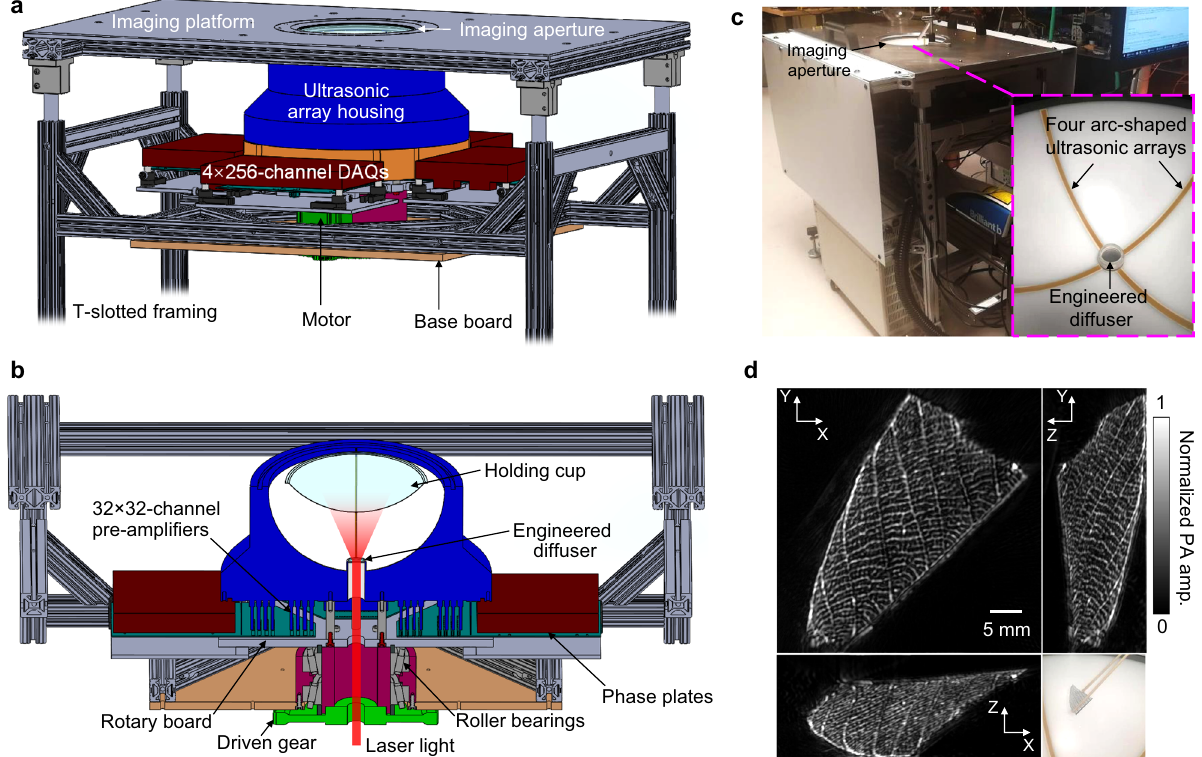
Fig. 1 Representations and photographs of the 3D-PACT system and the leaf skeleton images. a Perspective view of the system. DAQ, data acquisition module. b Cut-away view of the system with the imaging platform removed. c Photograph of the system with a close-up view of the ultrasonic arrays. d Photograph and maximum amplitude projection (MAP) images of a leaf skeleton reconstructed after geometric calibration (see